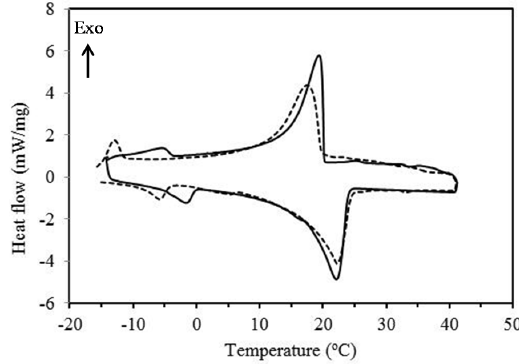
Figure 4. DSC curves of the bulk RT ‐ 21 (solid line) and M ‐ 2 microcapsules containing nucleating agent, RT ‐ 58 (dotted line). Table 1. Thermophysical properties of fabricated M ‐ 2 and commercial Micronal ® DS 5008 X.